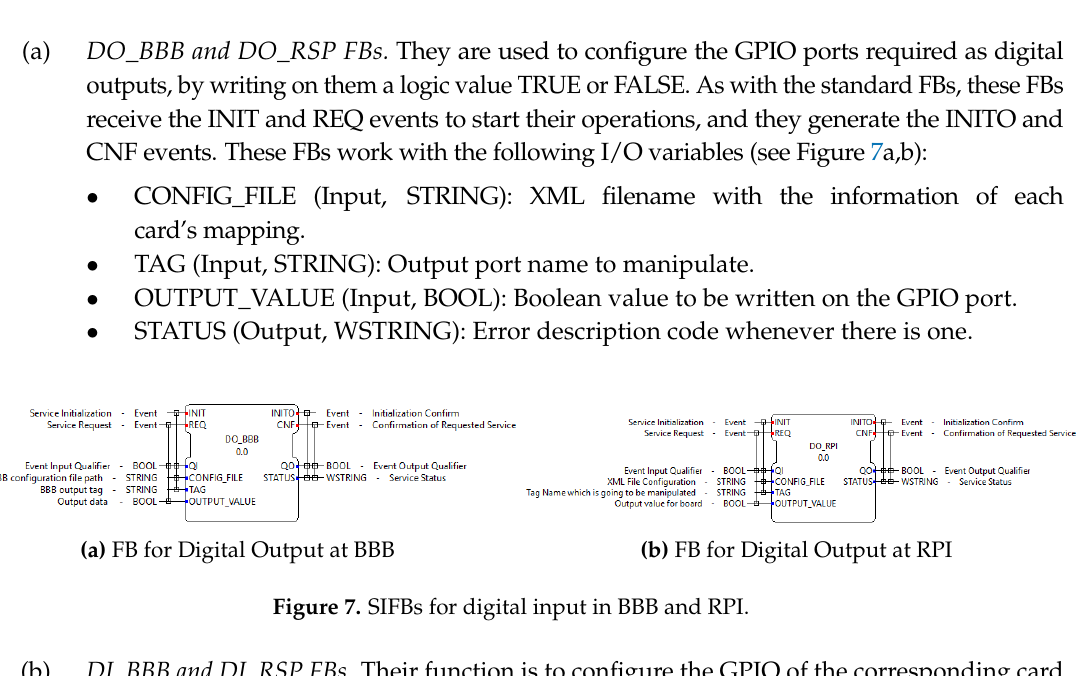
Figure 6. XML Schema Definition (XSD) configuration file for process tags.